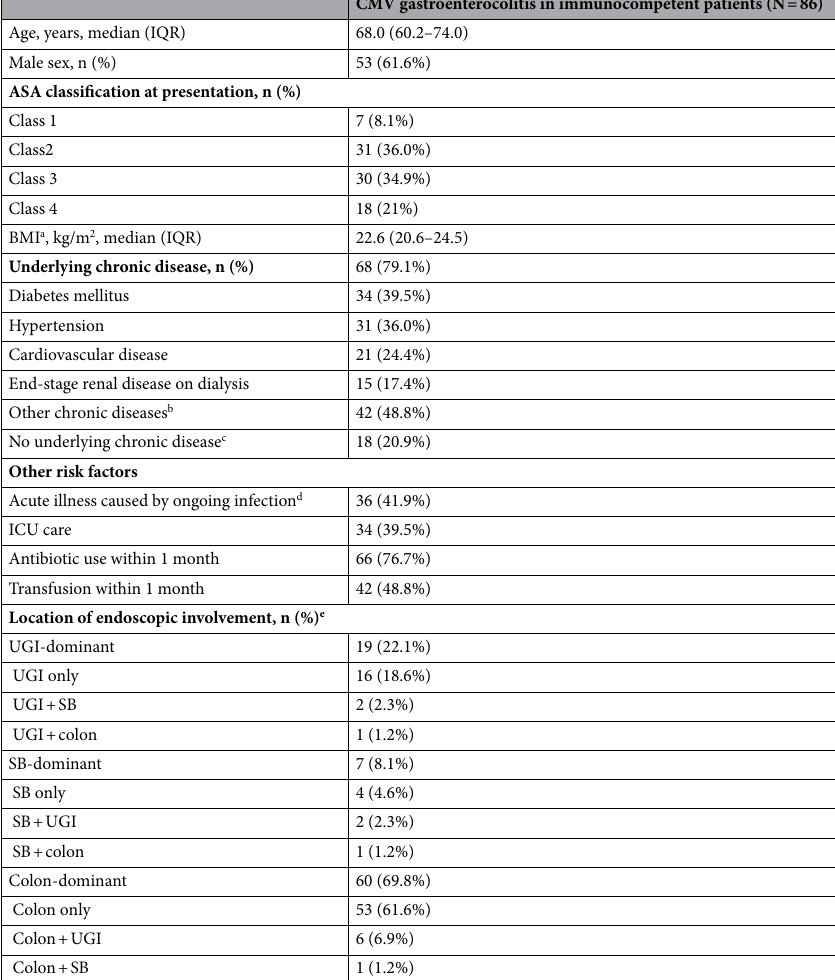
ganciclovir. Eight patients died during antiviral therapy with ganciclovir, seven of whom died of active comorbid conditions, such as pneumonia and liver failure, and one died of aggravating pneumonia plus GI bleeding from CMV colitis (Fig. 4). The other 35 of the 86 patients did not receive antiviral therapy because (1) their symptoms improved with supportive care before and around the histologic confirmative diagnosis of CMV gastroenterocolitis in 33 patients, or (2) emergency surgeries were performed in two patients with CMV colitis for cecal and rectal per- forations, respectively, before the histologic diagnosis of the endoscopy biopsy specimens. The UGI-dominant